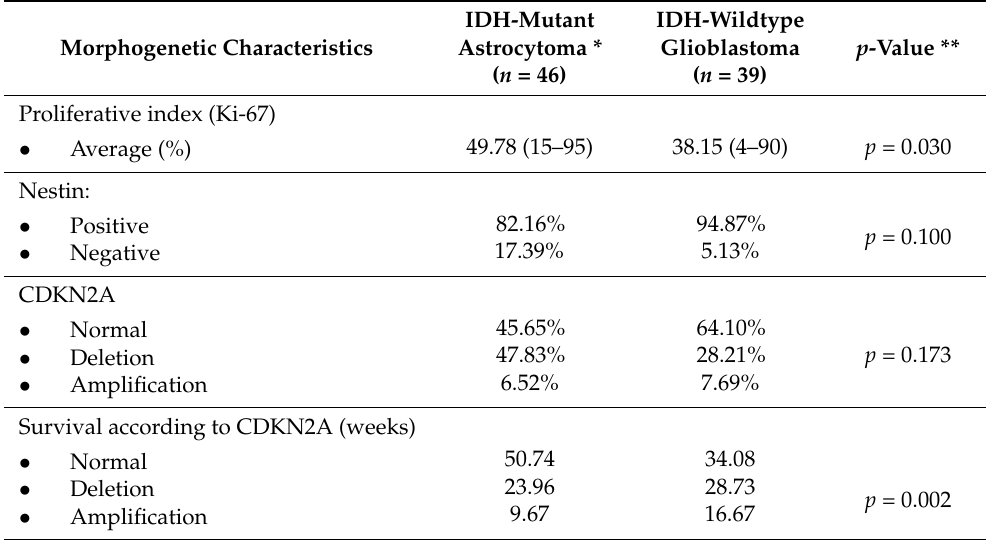
Table 3. Stratification after diagnosis of the main immunohistochemical and genetic aspects.